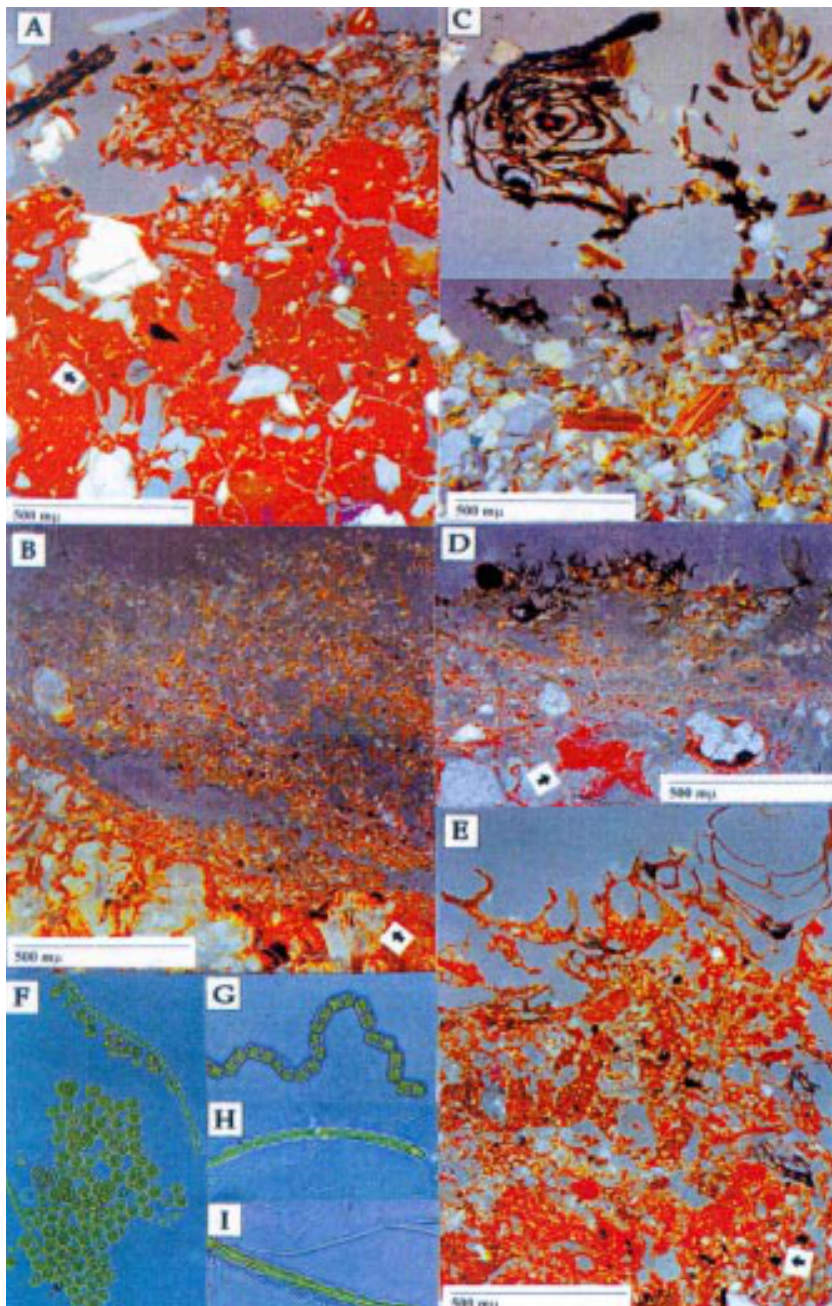
Figura 1. Fotomicrografias das crostas biológicas em A, B, C, D e E; e das cianobactérias desenvolvidas em meio de cultura, em F, G, H e I. A) Estrutura em blocos com incipiente desenvolvimento de cutans de tensão (zonas amareladas, seta) na superfície de agregados, notando-se ferruginização na parte superior da crosta (P2); B) crosta biológica bem desenvolvida, em P5, com abundantes micropontuações biogênicas e pseudomorfose de biotita em caulinita (seta), notando-se ferruginização acentuada na base da camada micropedogenizada; C) Briófitas em processo de decomposição sobre camada delgada, micropedogenizada em grãos simples (P4); D) Crosta de líquens e briófitas sobre tapete de algas decompostas, em P6, notando-se abundância de pontuações ferruginosas e zonas de plasma ferruginoso avermelhado (seta) no saprolito; E) Líquens foliosos, em P1, recobrindo horizonte micropedogenizado, com abundantes micronódulos ferruginosos (seta); F) Associações de colônias de algas unicelulares com algas filamentosas (200X); G) Junção de indivíduos unicelulares em forma de bastonetes formando filamentos multisseriados (400X); H) Algas filamentosas, apresentando talo multisseriado (400X); I) Filamento de alga com ramificações